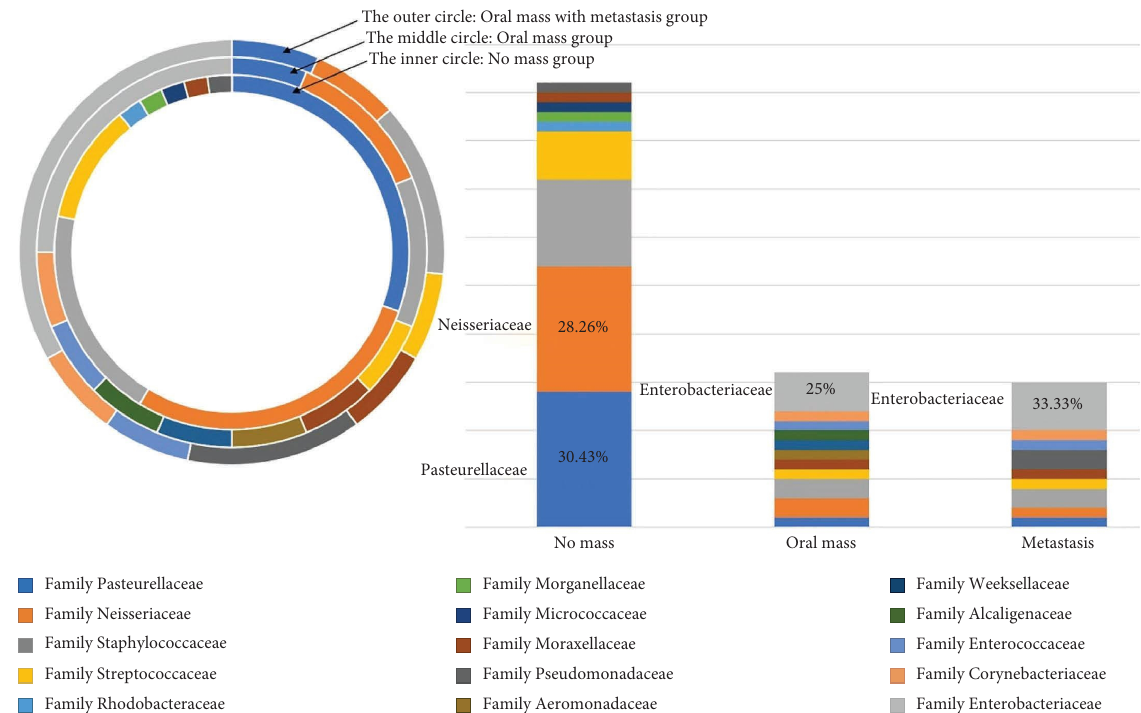
Figure 7: Family of the bacterial isolates which were analyzed based on 16S rRNA gene taxonomy from the canine oral swabs in the three groups of